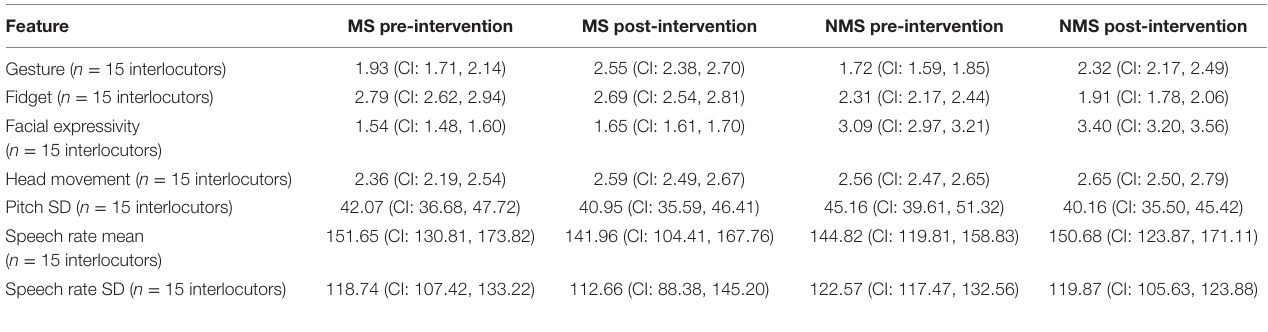
TaBle 1 | Descriptive statistics of individual behaviors before and after intervention by